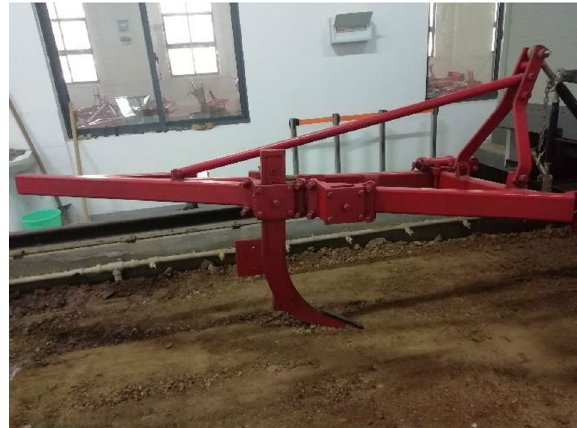
Figure 5. Subsoiler attached to the soil bin trolley.